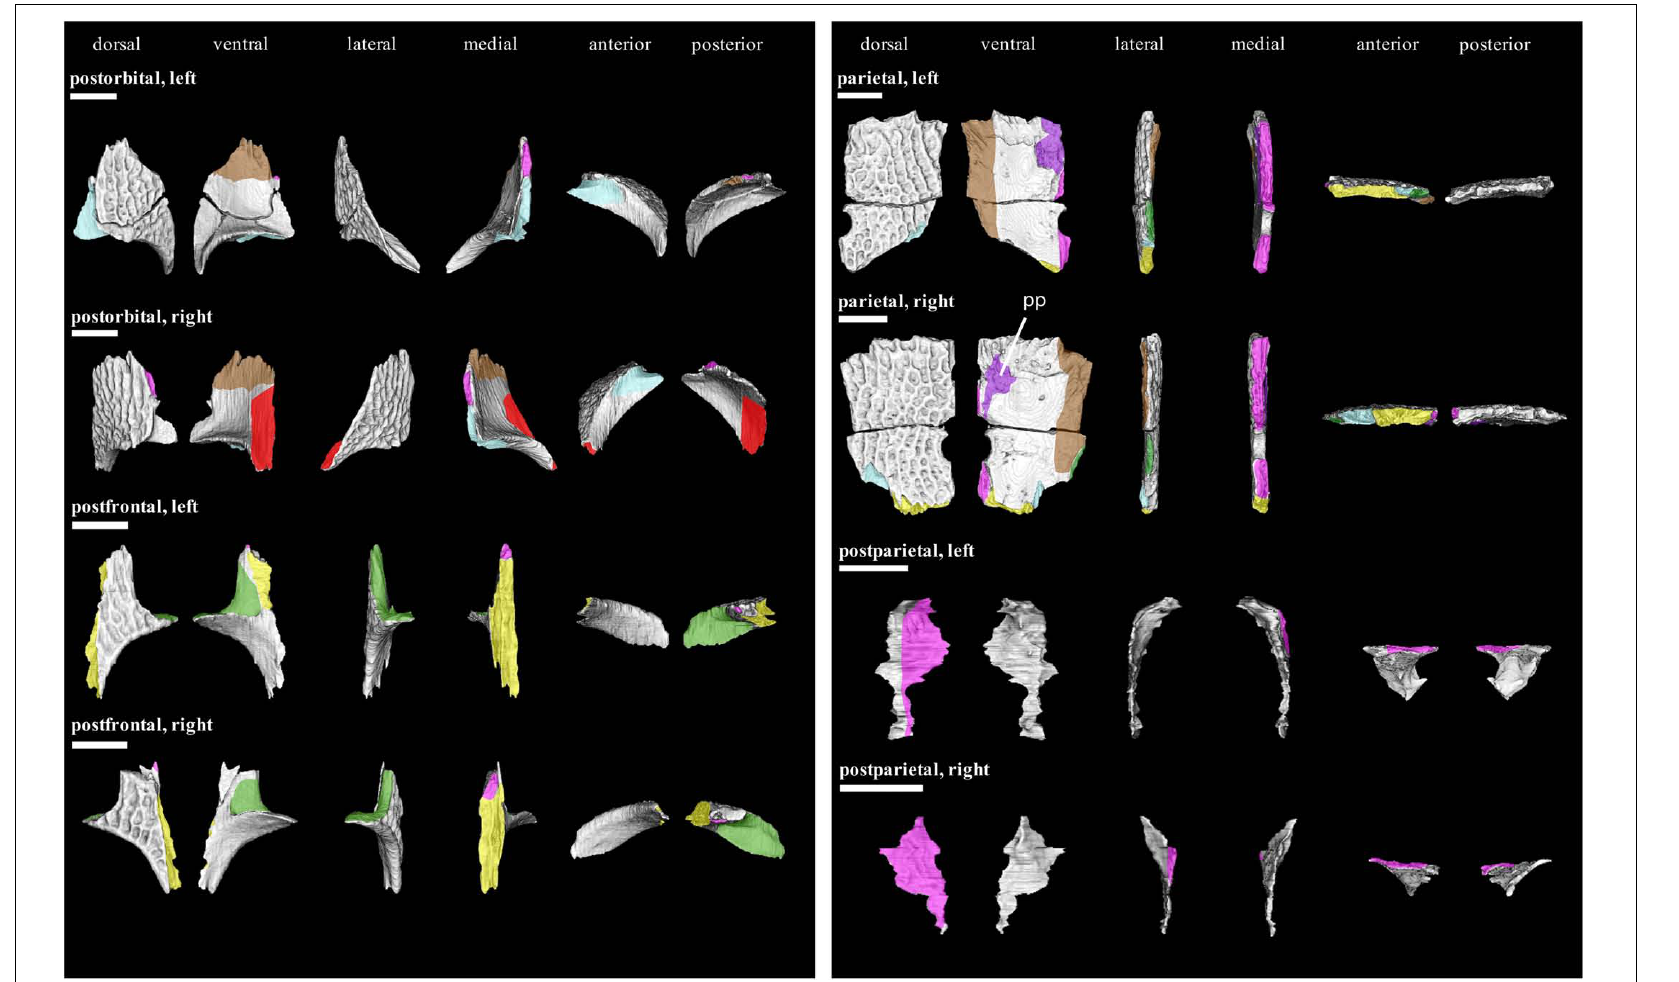
FIGURE 8 | Isolated bones in dorsal, ventral, lateral, medial, anterior and posterior views. Articulation areas with other bones are colored. Left and right postorbital, left and right postfrontal, left and right parietal, and left and right postparietal are shown. Scale bar = 10 mm. For abbreviations see caption to Figure 1